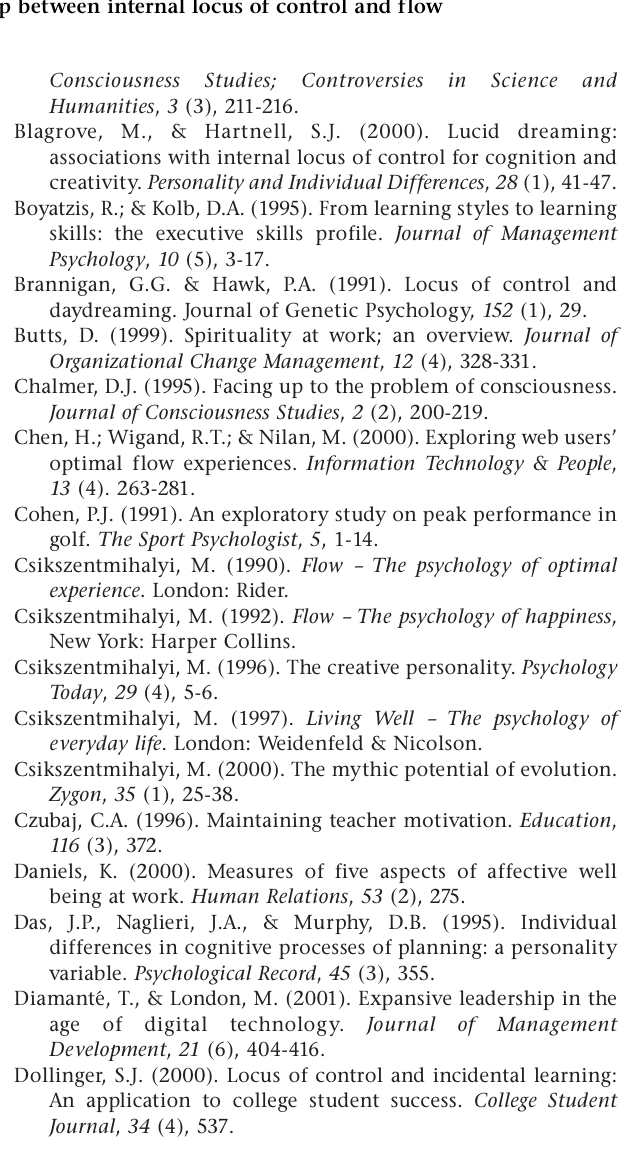
Figure 2: Proposed conceptual model of the relationship between internal locus of control and